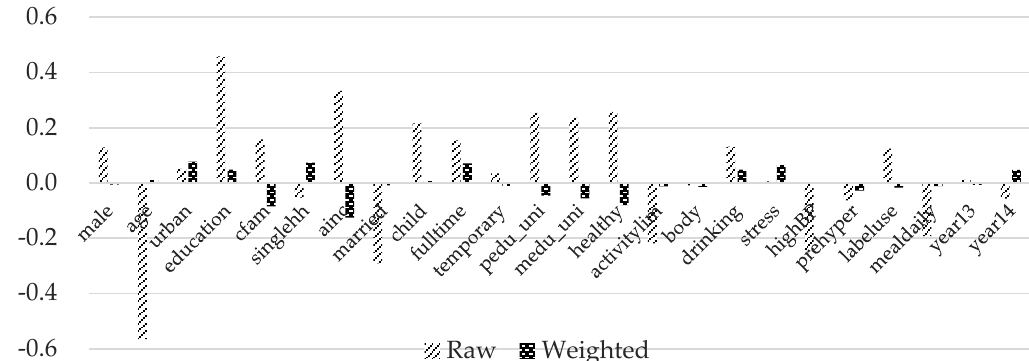
Figure 3. Standardized mean di ff erences of treatment group 1. Note: Detailed explanations of the variables are included in Table